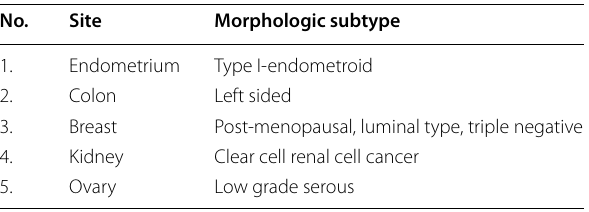
Table 1 Morphological subtypes of cancers related to obe-